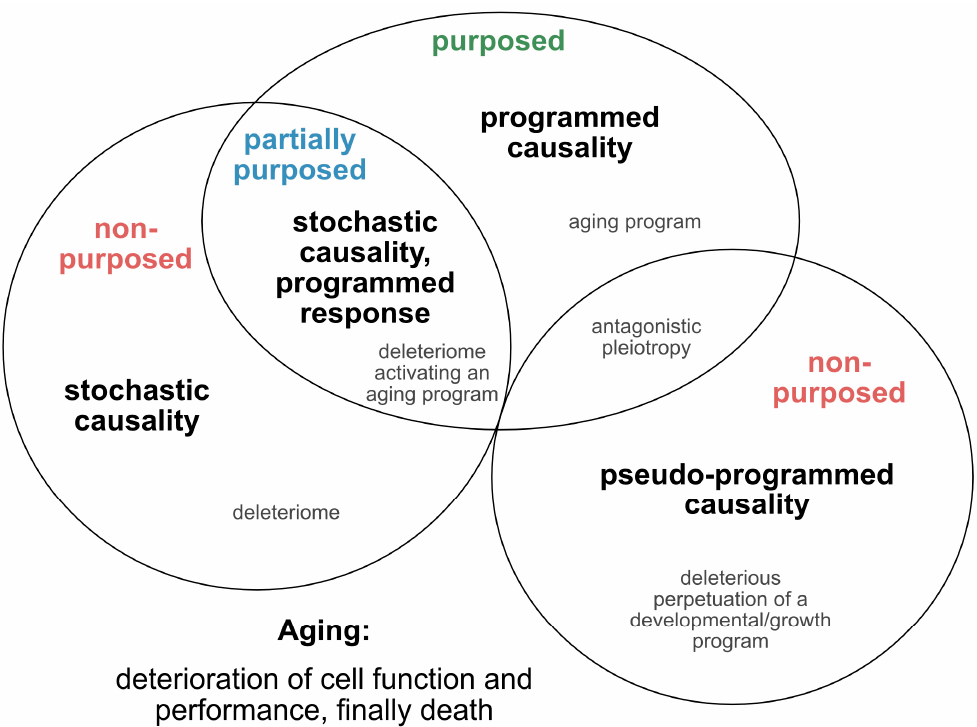
Figure 2. Theories on the causality and purpose of aging. Graphically summarized are four contrasting concepts crystallized from current evidence addressing the inductive driving force of aging. Apart from a stochastic deleteriome, there are arguments for a pseudo-programmed, programmed or at least partially programmed nature of aging.